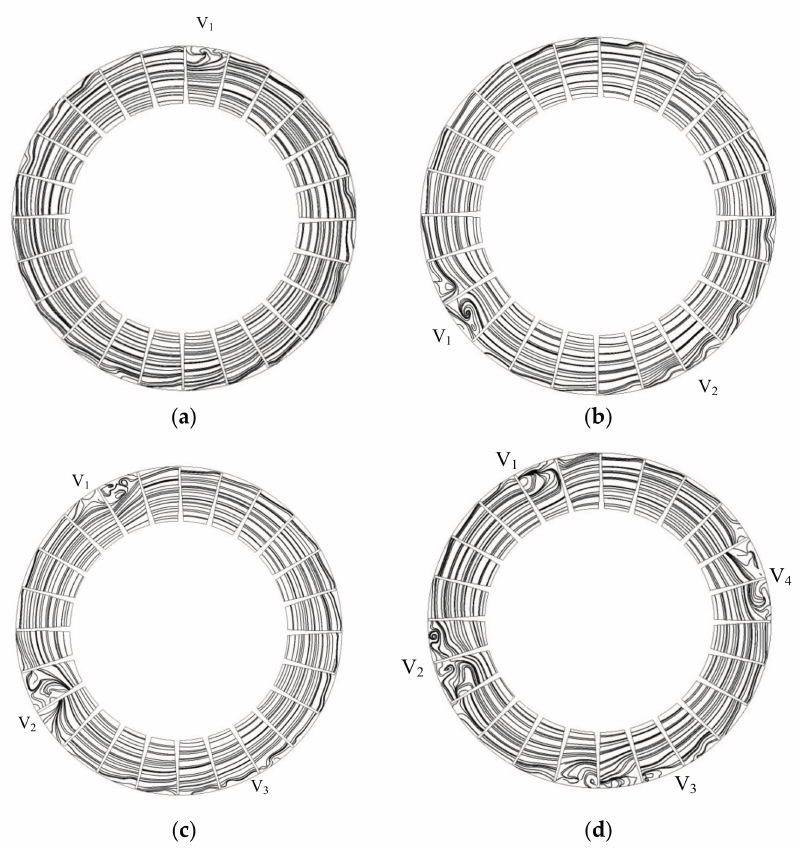
Figure 8. The distribution of relative velocity streamline at Z=0 Section: ( a ) T = 34.5th; ( b ) T = 36th; ( c ) T = 37.5th; and ( d ) T =